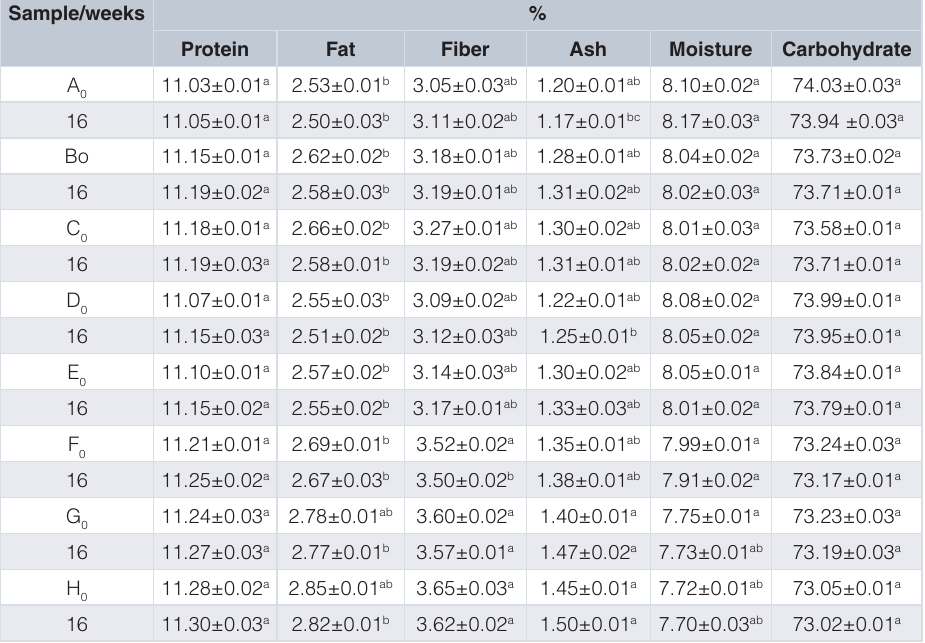
Table 2. Proximate Composition of Ogi (sorghum) flour with Garlic and